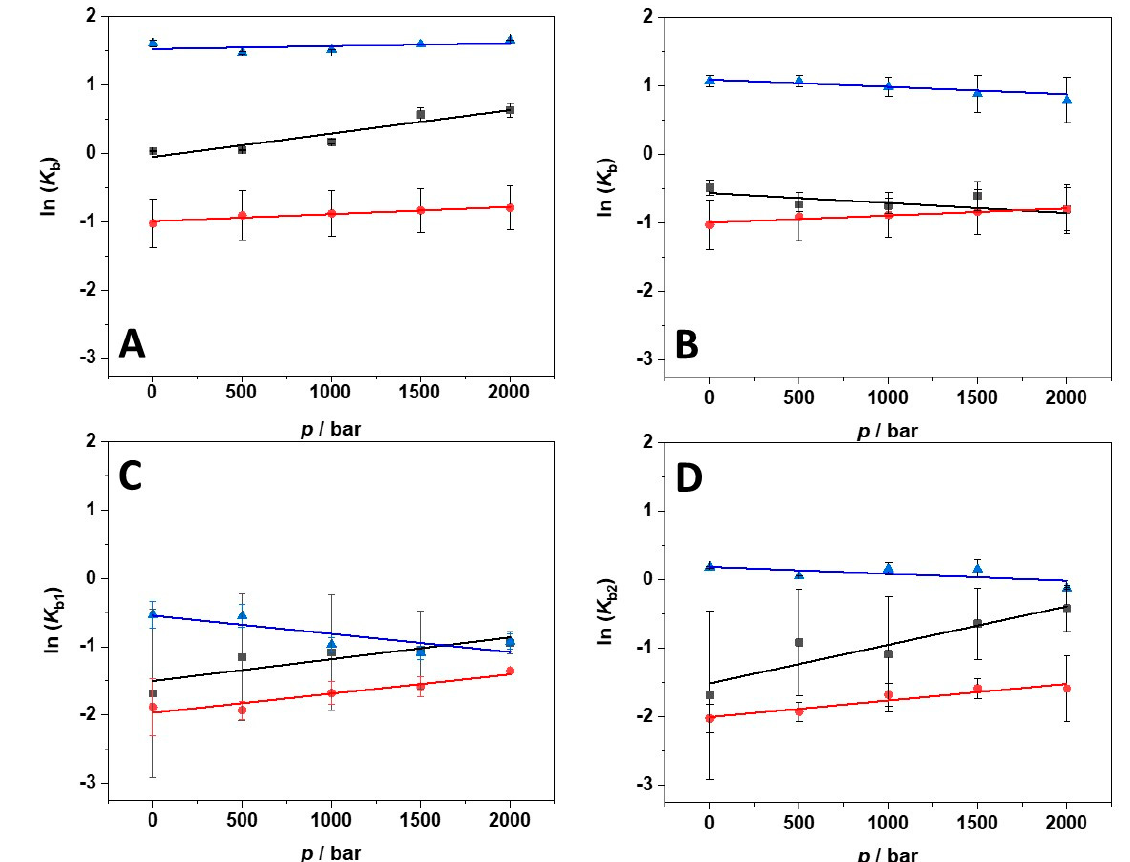
Figure 5. Pressure dependence of the binding constant ( K b ) for the complex formation between BSA and ANS in the presence of 250 mM MgCl 2 ( A ), MgSO 4 ( B ), and Mg(ClO 4 ) 2 ( C ) and ( D ) at the temperatures of 5 °C (black squares), 15 °C (red circles), and 25 °C (blue triangles). The plot in ( C ) refers to the pressure dependence of the binding constant of the first binding site ( K b1 ), the plot in ( D ) to that of the second binding site ( K b2 ). From the slopes of ln( K b ) vs. p , the binding volume ( Δ V b ) can be calculated by means of Equation 1.